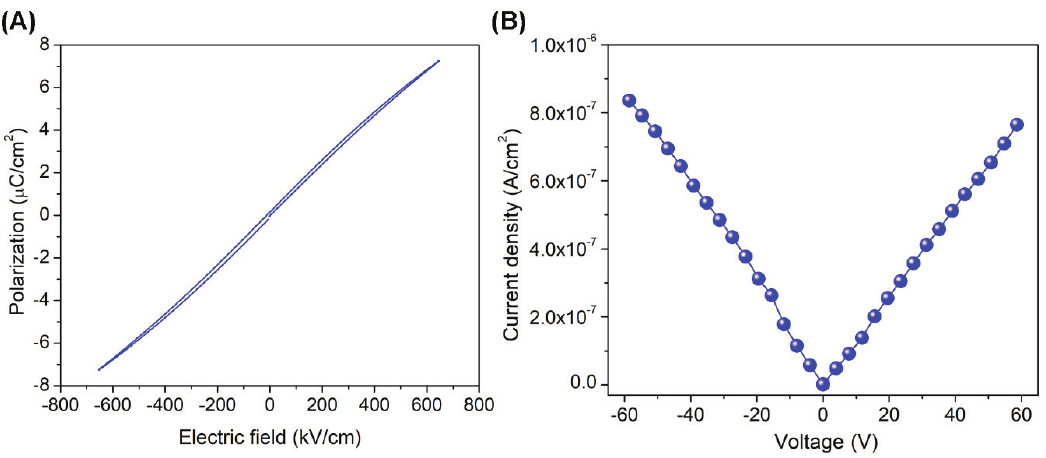
Figure 3. ( A ) The polarization-electric field ( P-E ) hysteresis loops measured at 100 Hz. ( B ) Leakage current density of the BSZT thin film capacitor as a function of the applied bias voltage at room